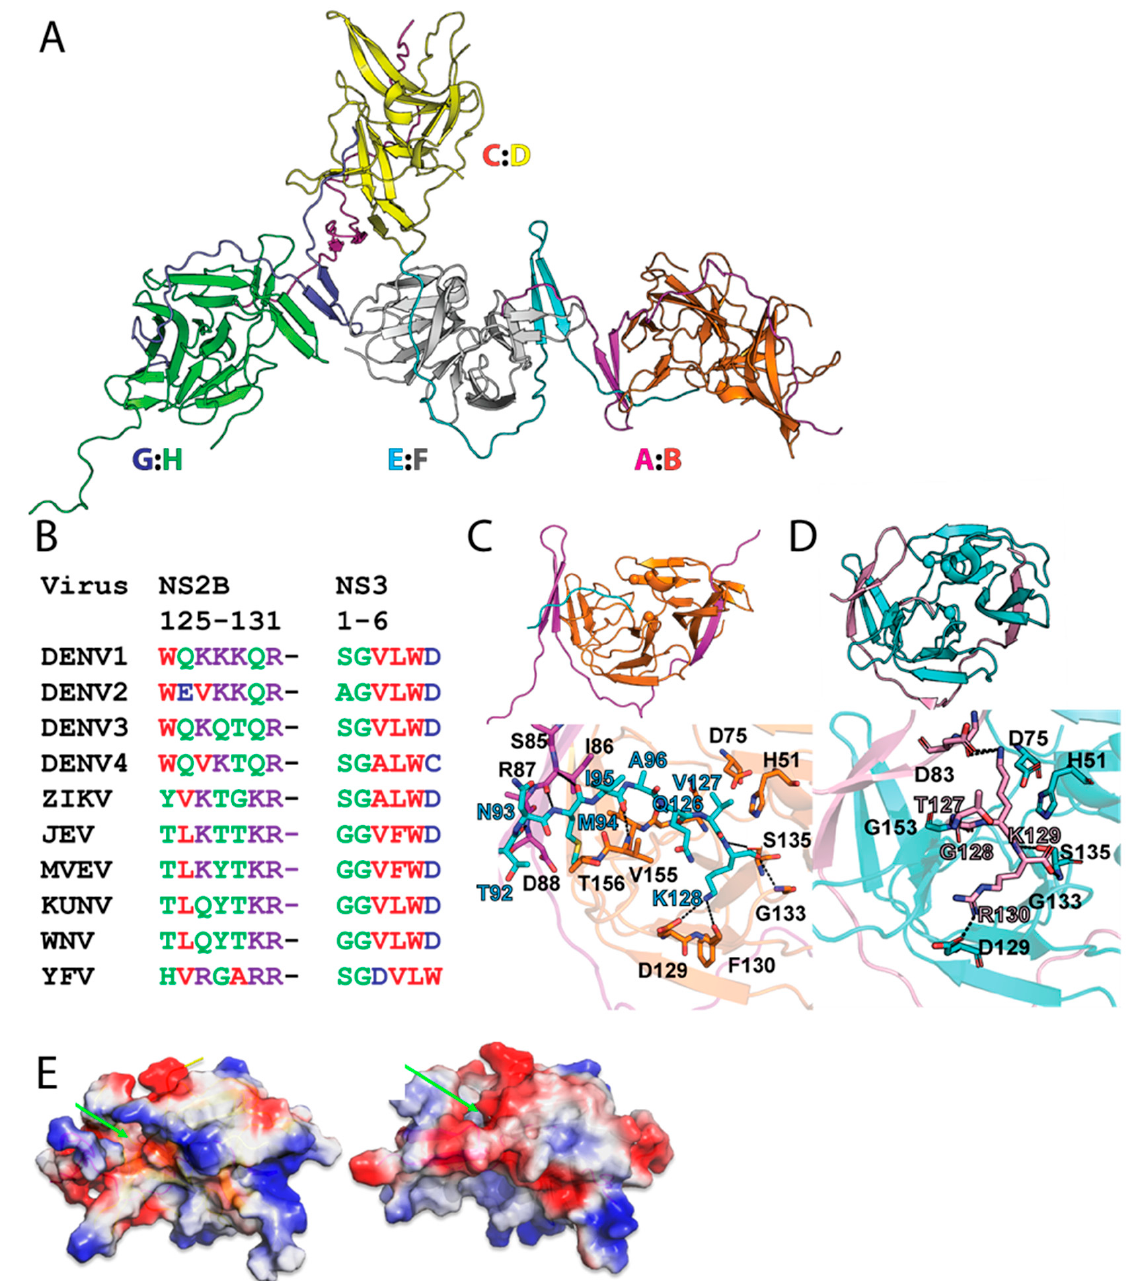
Figure 4. Crystal structure of eNS2B 47 NS3Pro reveals a novel conformation of NS2B cofactor. ( A ) One unit cell of eNS2B 47 NS3Pro shows the two dimer units. The NS3 domains are annotated as (B,D,F,H) and NS2B cofactor as (A,C,E,G). The chains’ IDs are indicated next to the molecule. ( B ) The sequence alignment of the NS2B-NS3 cleavage site for different flaviviruses. ( C , D ) Comparison between the active site of NS2B-NS3 protease from DENV4 ( B ) and ZIKV ( C ). The residues involved in the interactions are labelled and shown as sticks. The interacting residues are numbered and labelled with one amino acid code. The partially closed conformation of DENV NS2B-NS3 protease creates a larger active site allowing P4-P6 substrate residues to form interactions with NS2B. ( E ) Surface charge representation of DENV protease. Left: Partially closed conformation in eNS2B 47 NS3Pro. A small hydrophobic binding site could be observed during the partial opening of NS2B cofactor. Right: Fully closed conformation of NS2B cofactor (PDB: 3U1I).